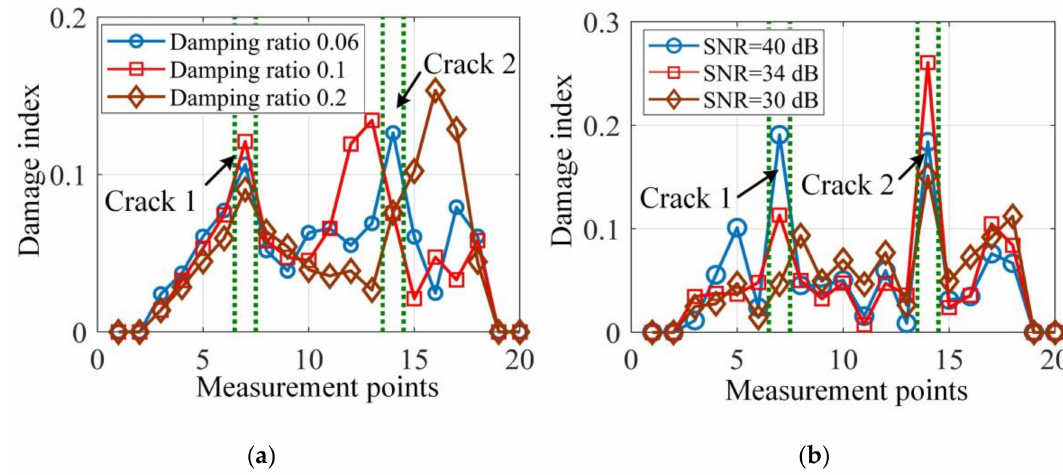
Figure 5. Damage localization results of two cracks with 5% depth reduction under ( a ) di ff erent damping ratios and ( b ) di ff erent noise